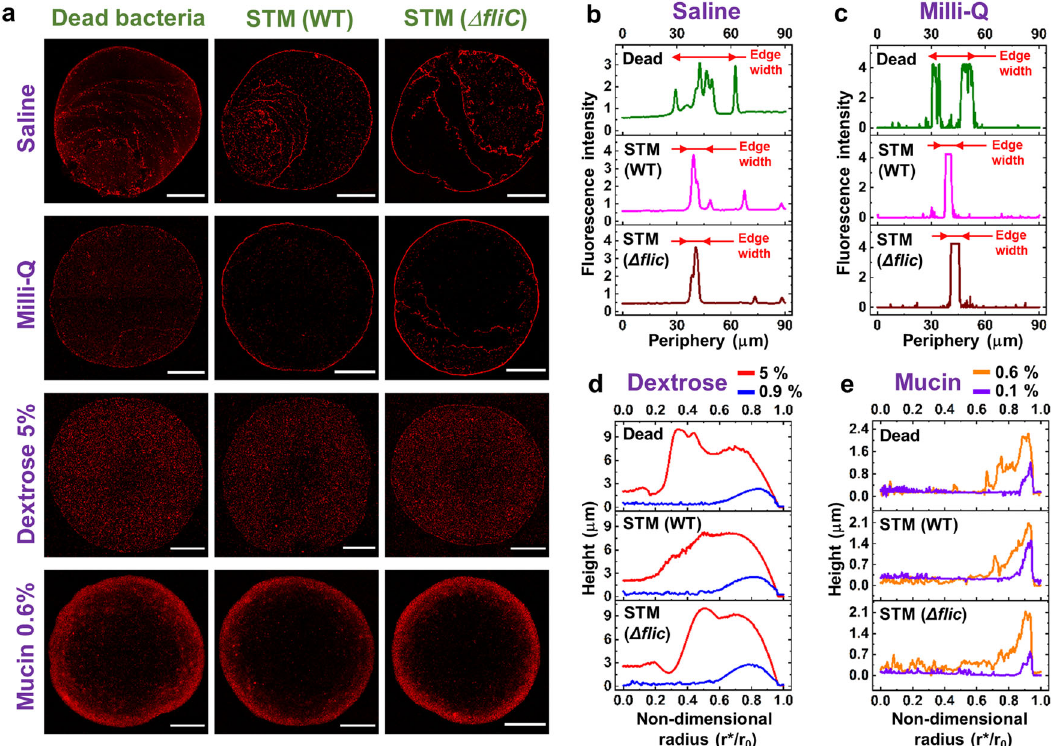
Fig. 2 Precipitates of droplets containing Salmonella bacterial strains in different media. a Confocal images (10× magni fi cation) of the droplet precipitates for dead bacteria, STM (WT), and STM ( Δ fl iC ) in saline, milli-Q, dextrose 5wt%, and mucin 0.6wt% media. Scale bars, 500 μ m. b Fluorescence intensity at the edge for dead bacteria, STM (WT), and STM ( Δ fl iC ) in saline medium (Supplementary Data 1). c Fluorescence intensity at the edge for dead bacteria, STM (WT) and STM ( Δ fl iC ) in milli-Q medium (Supplementary Data 2). d Radial pro fi lometry for dead bacteria, STM (WT) and STM ( Δ fl iC ) in dextrose 5wt% and 0.9wt% media (Supplementary Data 3). e Radial pro fi lometry for dead bacteria, STM (WT) and STM ( Δ fl iC ) in mucin 0.6wt% and 0.1wt% media (Supplementary Data